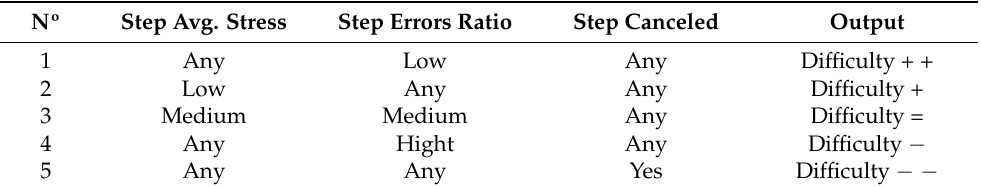
Table 2. Example rule set of the